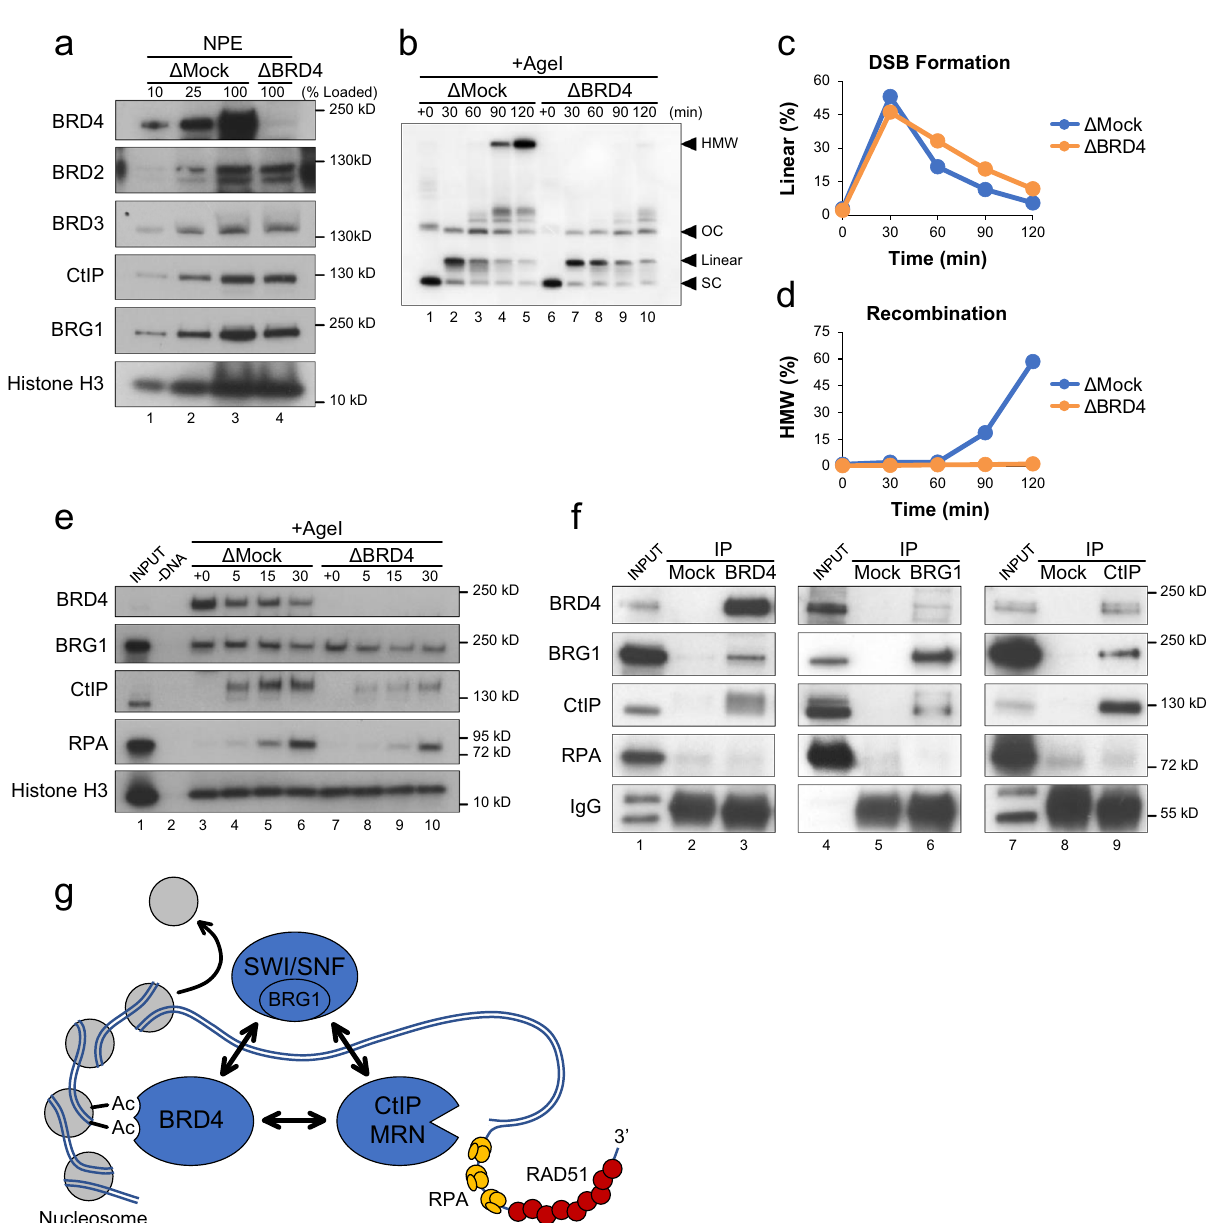
Fig. 4 BRD4 promotes resection and homology-directed repair. a Mock-depleted ( Δ Mock) or BRD4-depleted ( Δ BRD4) NPE was analyzed by Western blot using the indicated antibodies ( n = 2 independent experiments). b pDSB was replicated with α 32 P[dATP] in mock- or BRD4-depleted extracts. After 60 min, reactions were supplemented with AgeI and samples were isolated at the indicated time points for 1D gel electrophoresis ( n = 2 independent experiments). c , d Quantitation of linear ( c ) and HMW ( d ) molecules from ( b ). e pDSB was replicated in mock- or BRD4-depleted extract. After 60 min, reactions were supplemented with AgeI and DNA-bound proteins were isolated by plasmid pull-down. Samples were analyzed by Western blot with the indicated antibodies ( n = 2 independent experiments). f A mixture of HSS and NPE was immunoprecipitated with beads conjugated to mock, BRD4, BRG1, or CtIP antibodies. Bead-bound proteins were analyzed by Western blot with the indicated antibodies ( n = 3 independent experiments). g Schematic showing interactions between BRD4-BRG1-CtIP and their role in coordinating DSB repair through nucleosome eviction, DNA end resection, and homologous recombination. Acetylation (Ac); Mre11-Rad50-Nbs1